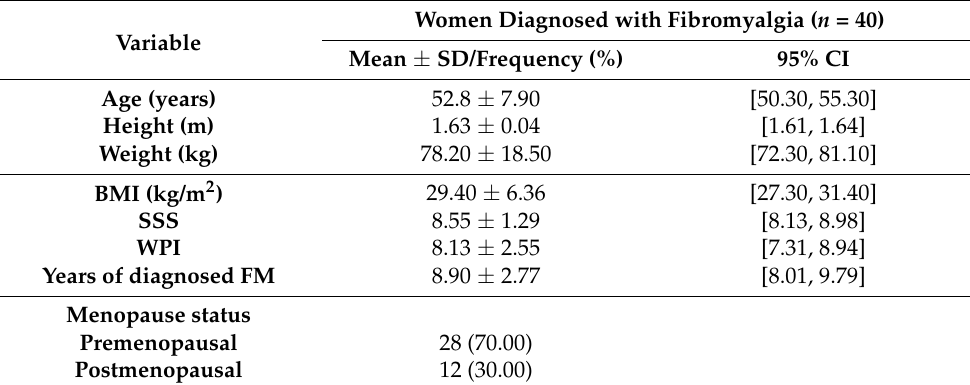
Table 2. Summary of sociodemographic data of the women diagnosed with Fibromyalgia.